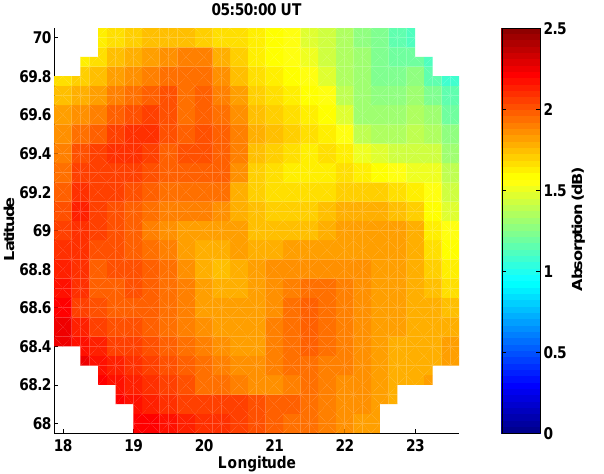
Fig. 8. The background level of absorption during Event 1. This is the mean background absorption over the 10-min interval from 05:50 to 06:00 UT.